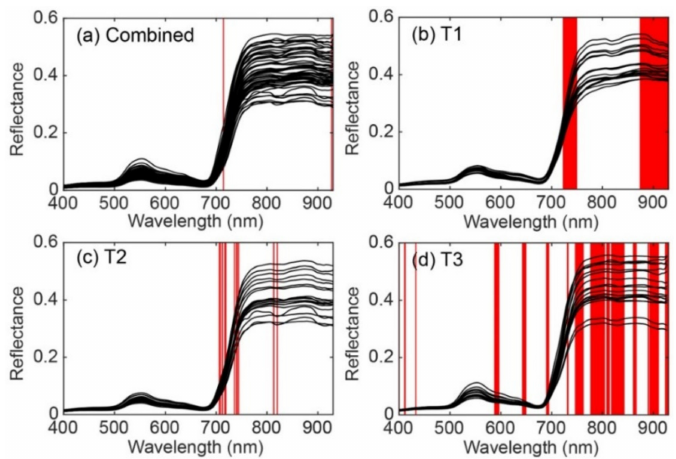
Figure 8. Canopy reflectance and selected wavebands (red bars) in the ISE-PLS models for the ( a ) combined ( n = 54) and ( b ) T1, ( c ) T2, and ( d ) T3 data sets ( n = 18 per transplanting date). Table 3. Selected wavebands from the iterative stepwise elimination partial least squares (ISE-PLS) model to predict grain yield via previously known absorption features in the visible and near-infrared (NIR)